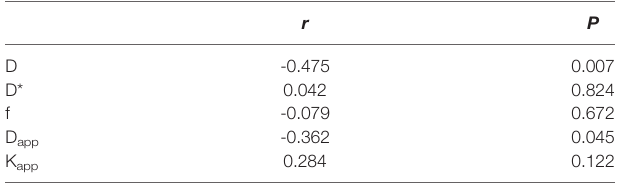
TABLE 7 | The correlation analysis between Ki-67 and quanti fi cation parameters of IVIM and DKI in thyroid papillary